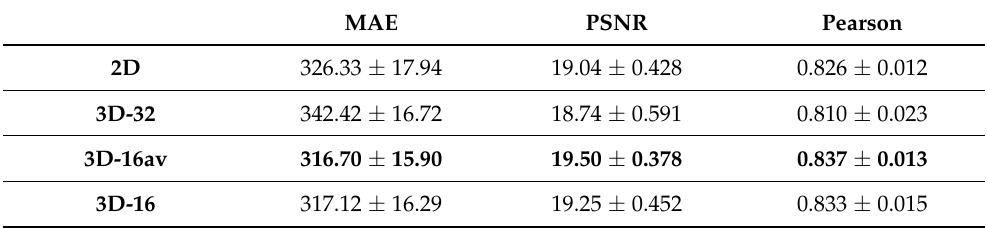
Table 6. Head dataset Bone with Residual-Net. Mean Absolute Error, PSNR and Pearson coefficient within the bone on the head data set obtained using Residual net with different convolutions and reconstructions.